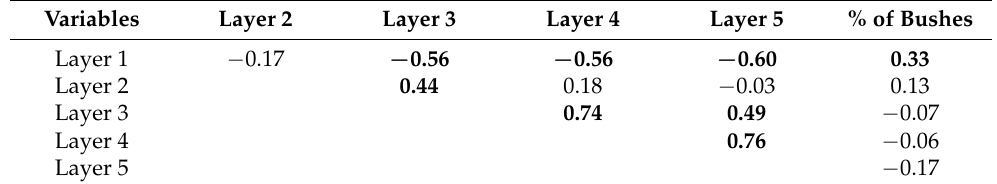
Table 2. Spearman’s rank correlation coefficients among different vegetation layers. Statistically significant relationships at p < 0.05 are in bold. See Table 1 for vegetation heights for each layer. Variables Layer